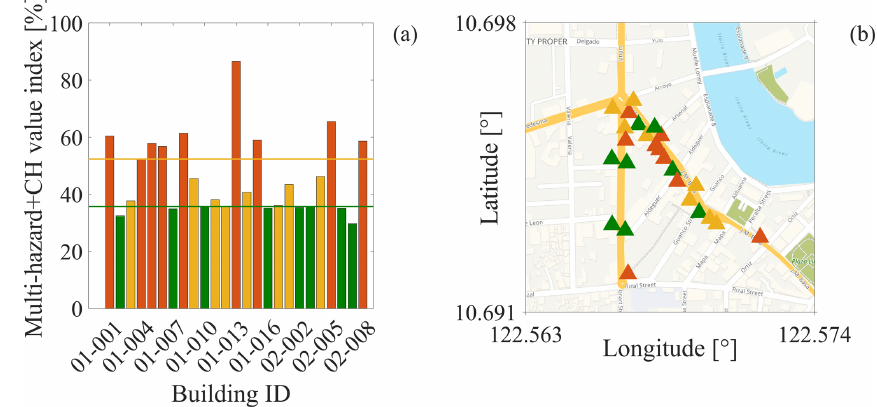
Figure 9. Multi-hazard risk prioritisation index which considers the intangible value of CH. Background map by © OpenStreetMap contrib- utors, 2019. Distributed under a Creative Commons BY-SA